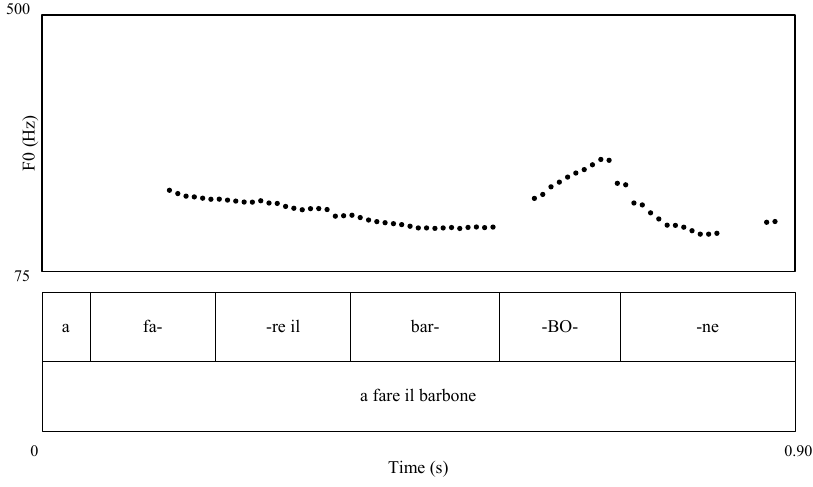
Figure 7. Rising-falling contour for seeking confirmation (‘becoming a hobo?’), produced by Sofia in Extract (11).